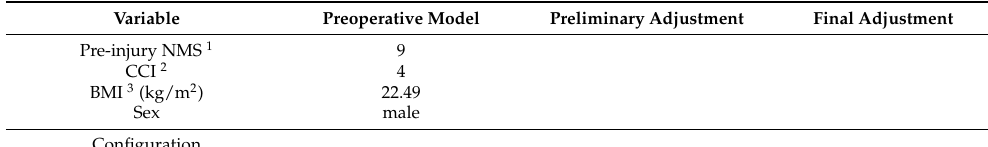
Figure A4. To demonstrate the use of the IT-AP tool, an example of 75-year-old male patient presented with left hip pain after a simple fall diagnosed as intertrochanteric fracture information was applied to the application. After the required data was inputted (pre-injury NMS = 9, CCI = 4, BMI = 22.49 kg/m 2 ) in the IT-AP tool application under the preoperative model option, the application calculated the likelihood ratio of good ambulatory status after receiving operation (LHR+ = 4.7) and have been informed to the patient. The patient was then transferred to the secondary hospital under specialists’ care and scheduled for closed reduction and internal fixation with an intramedullary device. The fracture was classified as AO/OTA 31A1 with a lateral wall thickness of 33.86 mm ( a , b ). Right after fracture reduction with near anatomical reduction was conducted (NSA = 129, neutral reduction in both dimensions) and internally fixed (CalTAD = 29.86, Parker’s ratio = 42%) ( c , d ), the IT-AP tool revealed a likelihood ratio of 10.59 to which surgeon decided to proceed with the skin closure and finish the operation. Table A3. A clinical application demonstration of the IT-AP